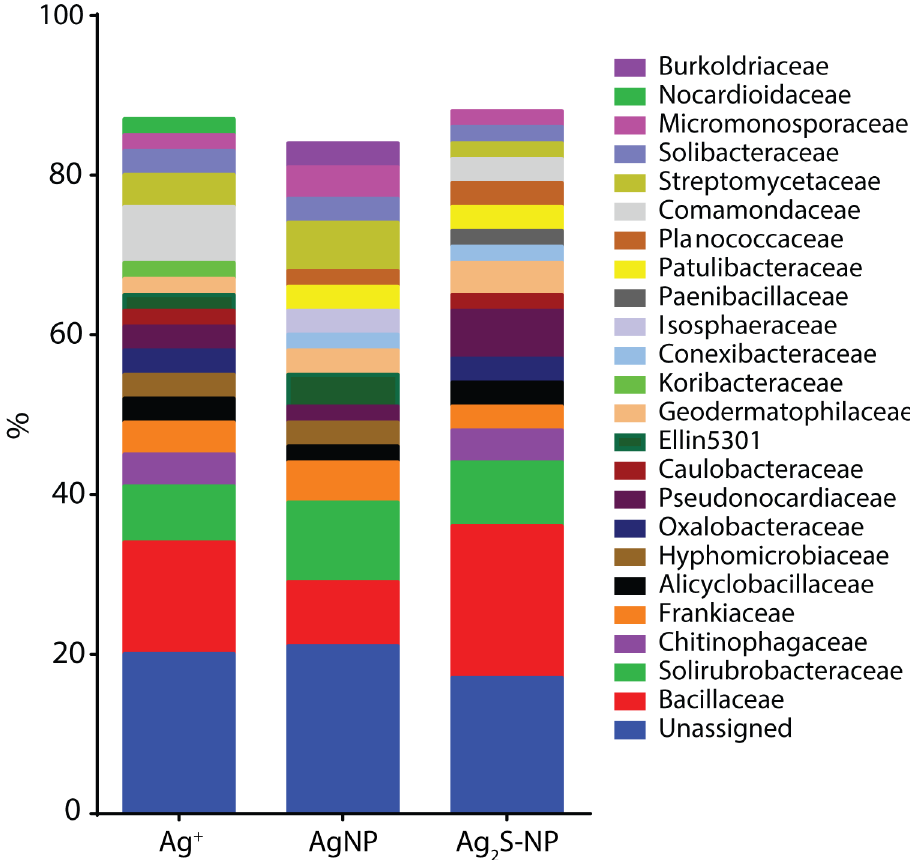
Fig 5. Taxonomy of the OTUs that were successfully fitted to the dose-response models. For clarity, only the bacterial families that contributed (cid:3) 2% to the overall distribution are shown. Unassigned OTUs are unclassified at the family level but are classified at higher taxonomic